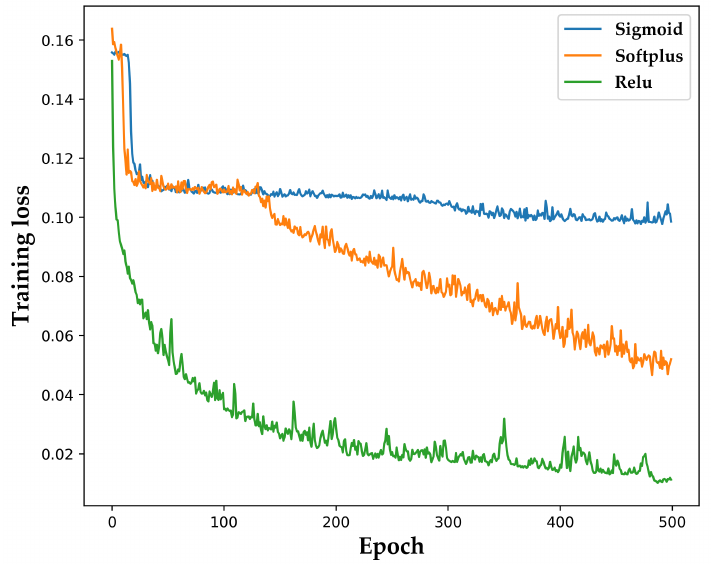
Figure 8. Performance comparison of different activation